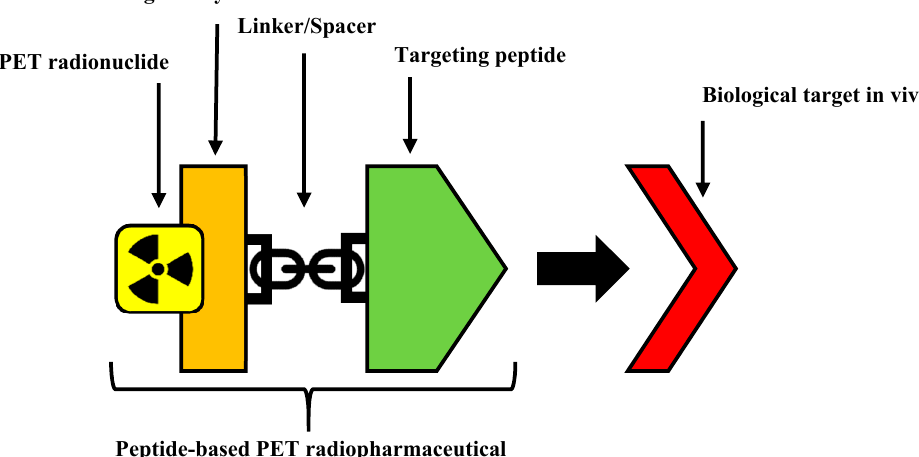
Figure 1. The structural components of a peptide-based positron emission tomography (PET) radiopharmaceuticals.